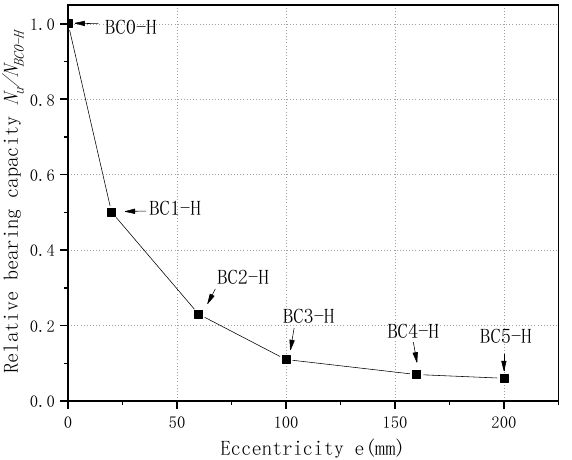
Figure 8. The curve relative bearing capacity vs. eccentricity.